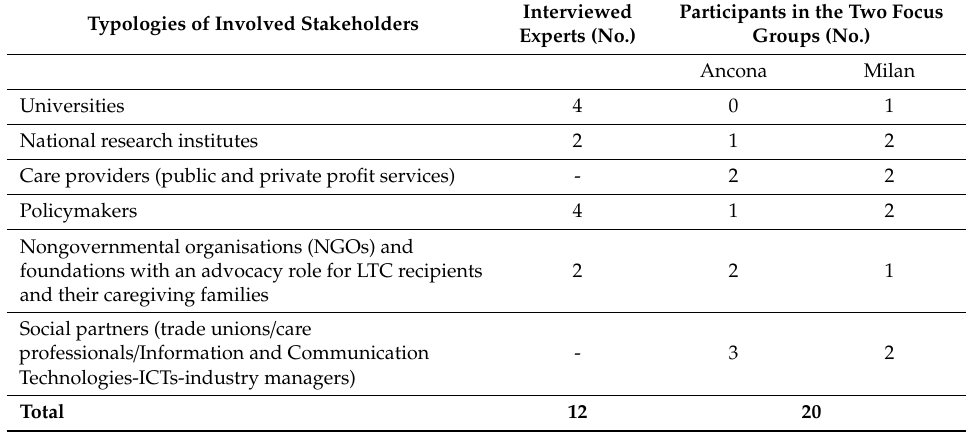
Table 1. Typologies and number of stakeholders involved in the study via expert interviews and focus